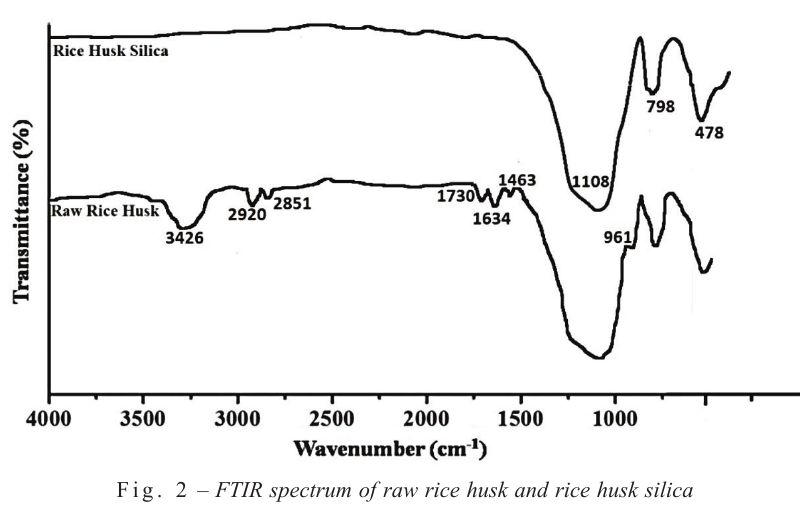
Fig. 2 – FTIR spectrum of raw rice husk and rice husk silica